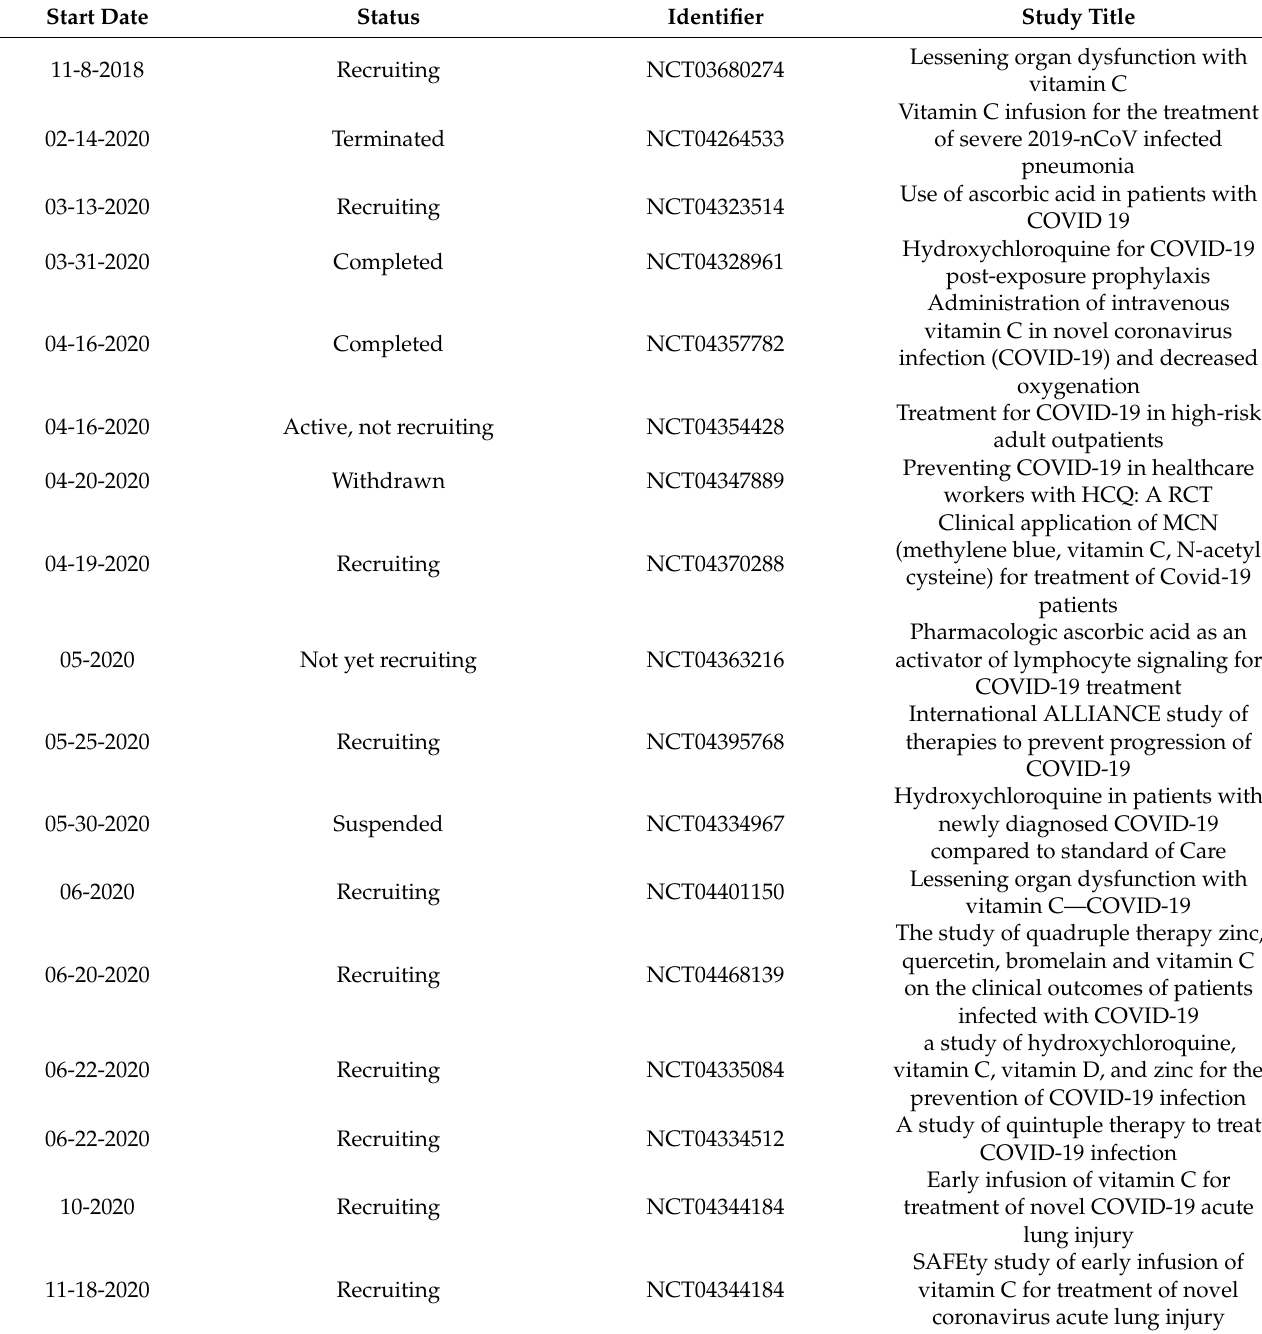
Table 2. An updated list of registered clinical trials to test the use of vitamin C in the treatment of COVID-19 at